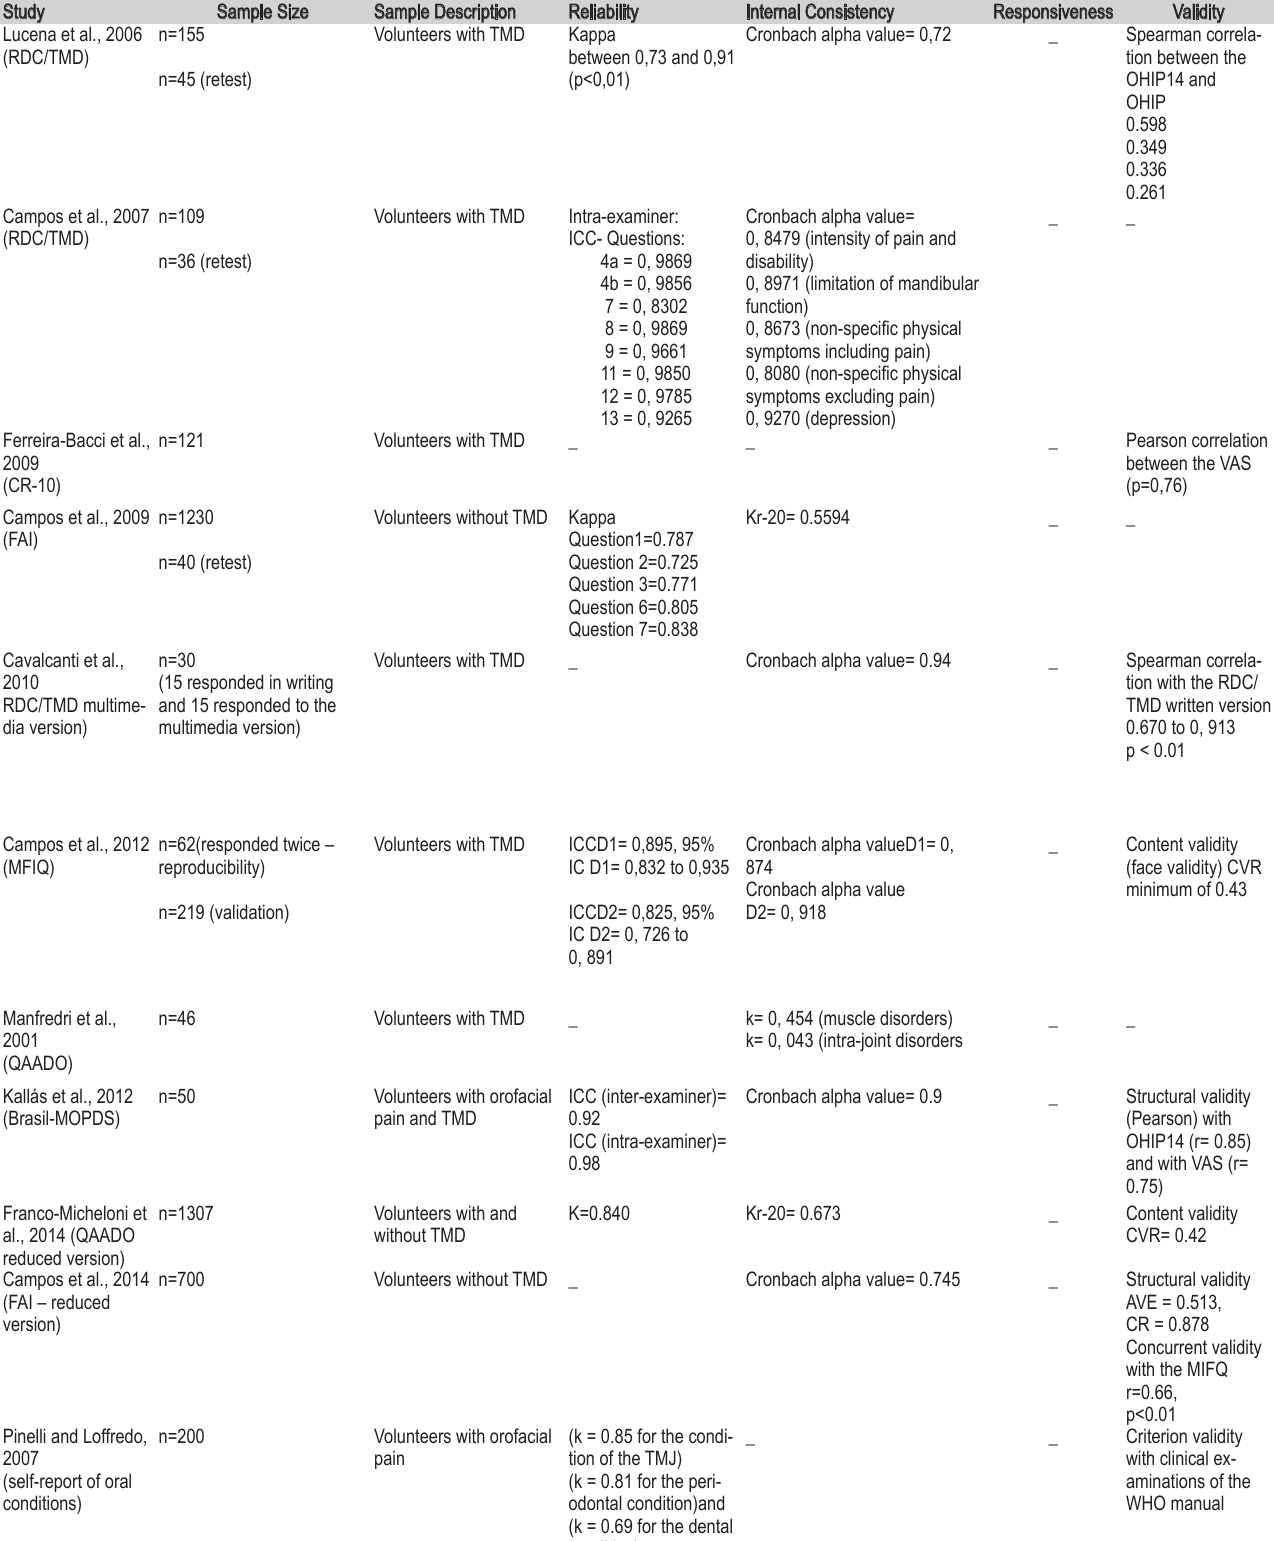
Table 1 - Classification of the measurement properties of the articles included in the review according to the COSMIN